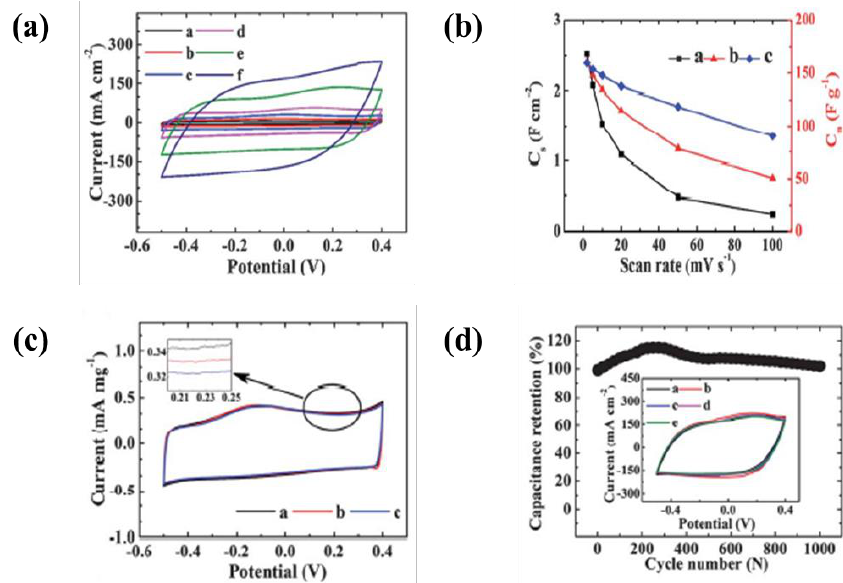
Figure 21. ( a ) Cycle performance of PPy–MWCNTs (10 wt.%) hybrid electrode dispersed using MG at various scan rates (a: 2, b: 5, c: 10, d: 20, e: 50, and f: 100 mV · s − 1 ); ( b ) Corresponding C s (area) and C m (mass) values obtained from the CV data versus scan rate; ( c ) Cycle performance of the PPy–MWCNTs (10 wt.%) hybrid electrode dispersed using MG at a scan rate of 2 mV · s − 1 (mass loading of MG of a: 20, b: 25, and c: 30 mg · cm − 1 ); ( d ) Capacitance retention versus cycle numbers of PPy–MWCNTs (10 wt.%) hybrid electrode dispersed using MG of 30 mg · cm − 1 (inset shows CVs. at a scan rate of 50 mV · s − 1 ).